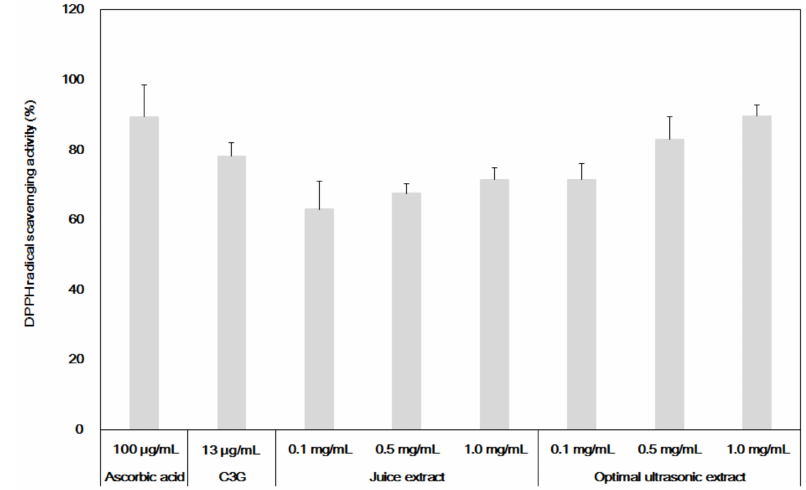
Figure 4. Comparison of antioxidant activities of the extracts from optimized ultrasonic process, juice extraction, and pure C3G, along with ascorbic acid as a positive